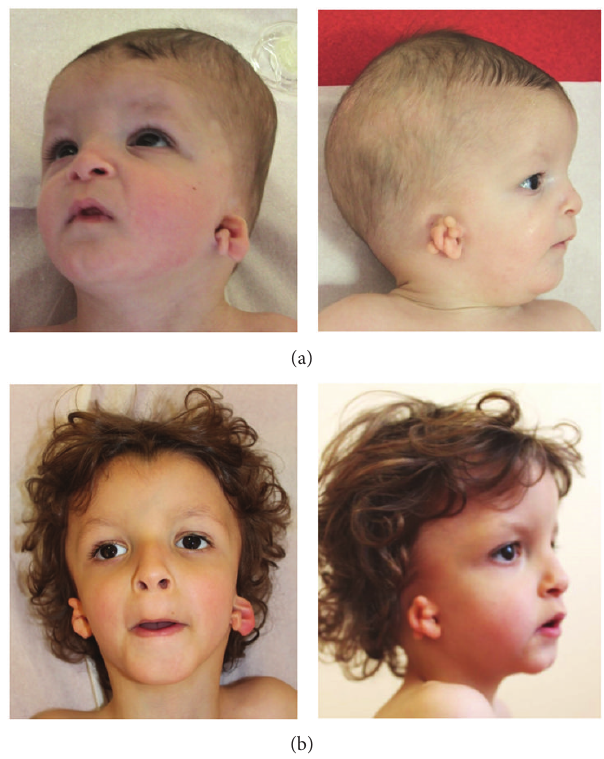
Figure 1: Craniofacial dysmorphism. Pictures of the patient at the age of 6 months (top panel) and 3 and a half (bottom panel). The facial dysmorphism consisted in hypertelorism, downslanting palpebral fissures, a thin upper lip, retrognathism, an irregularly shaped skull, and severe malformation of the external